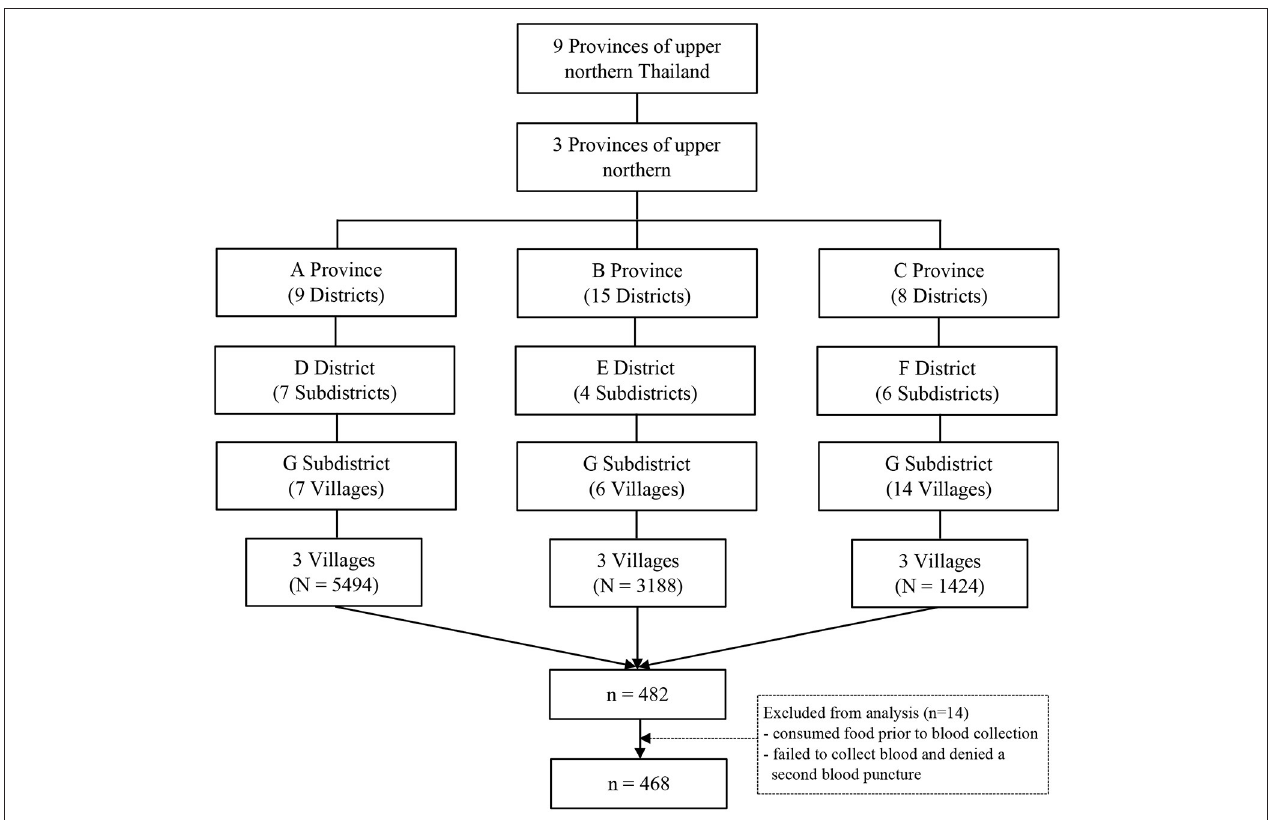
FIGURE 1 | Flow diagram of